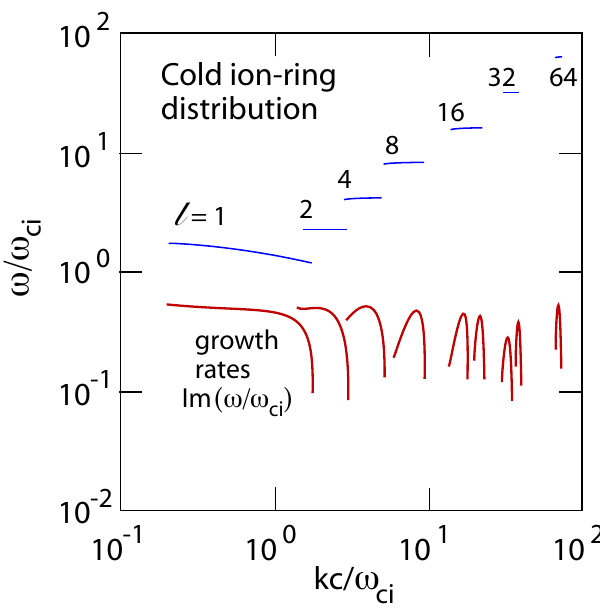
Fig. 3. Ion-cyclotron maser dispersion relation. Harmonic frequencies (blue) and growth rates (red) excited by a cold relativistic proton-ring distribution in an electron-proton plasma with ring- Lorentz factor γ ib < 10 ,N ib /N ∼ 10 − 2 (re-scaled data taken from Amato and Arons, 2006). The ring-ion maser generates a large number of ion cyclotron harmonics ‘ , all of nearly same maximum growth rate. The ion-cyclotron harmonics are equally spaced. In this figure, however, we have chosen for a logarithmic frequency scale in order to show a large number of harmonics and their growth rates. In order not to overload the figure we plotted only selected harmonics ‘ = 2 n , n ∈ N .